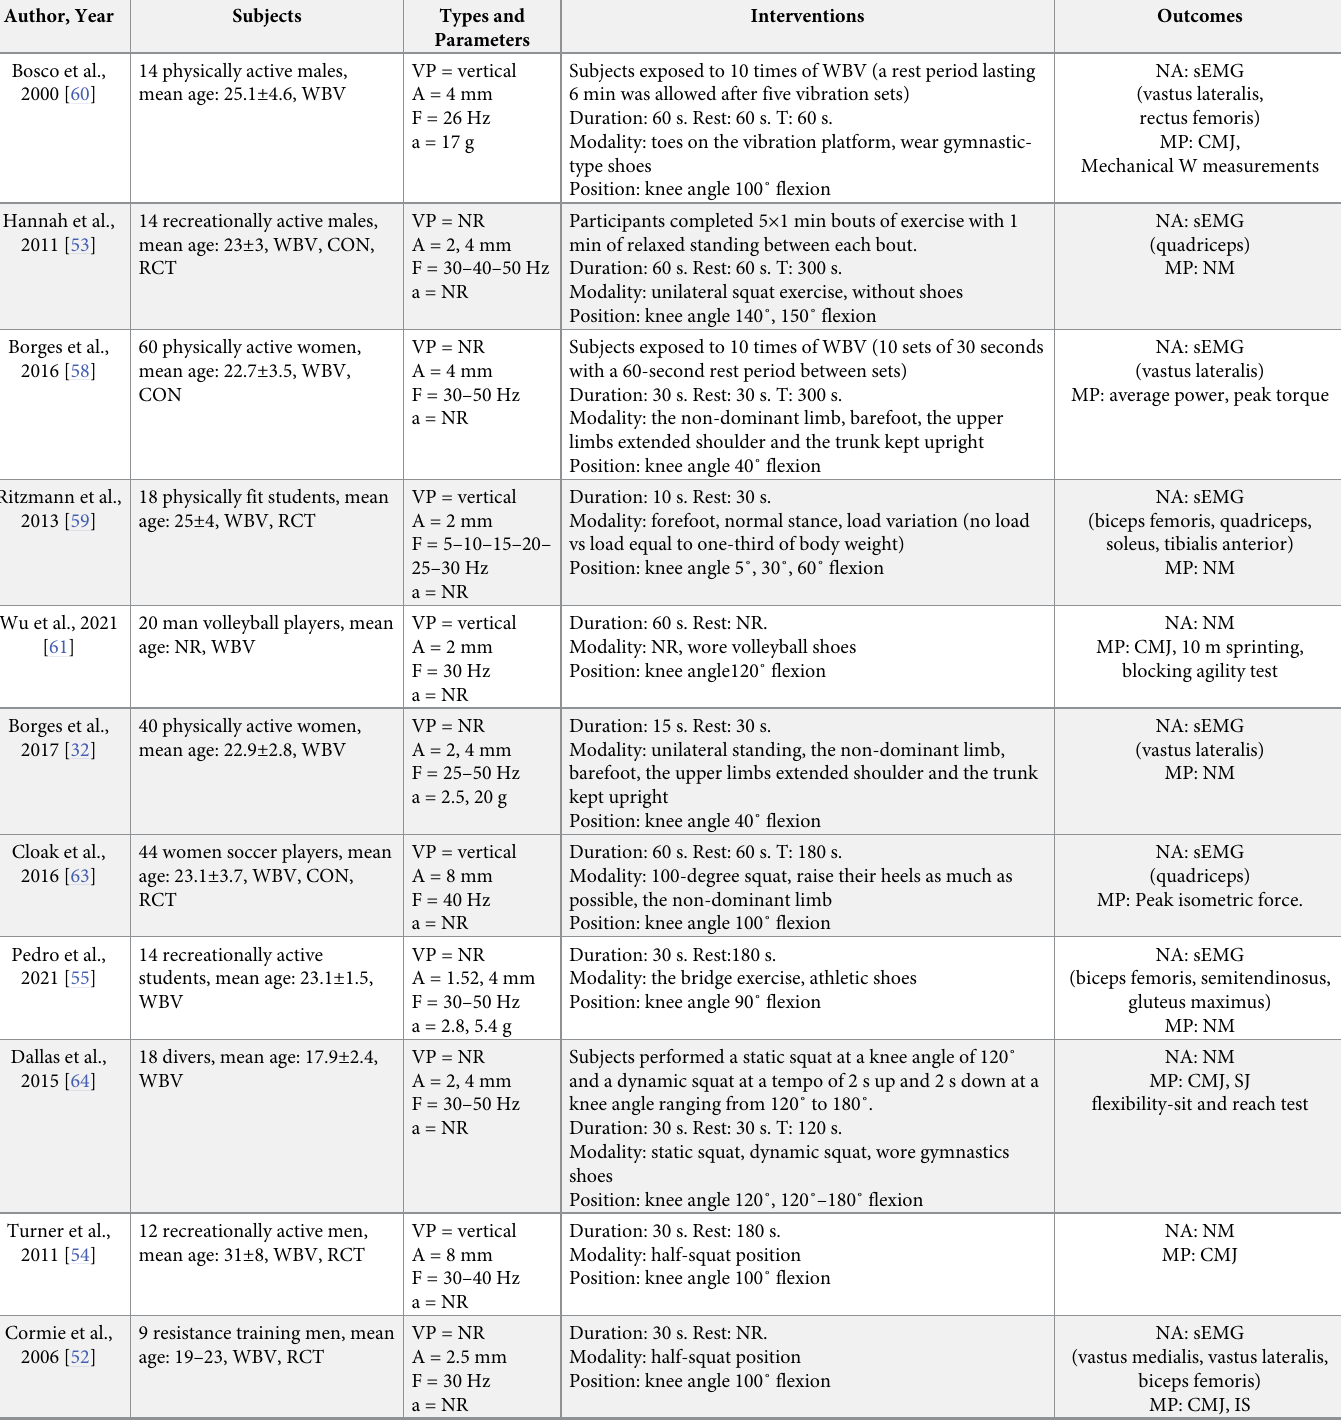
Table 1. Description of the characteristics of the included